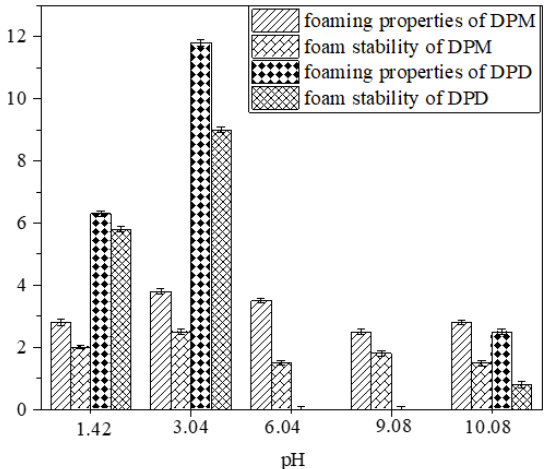
Figure 6. Foaming properties and foam